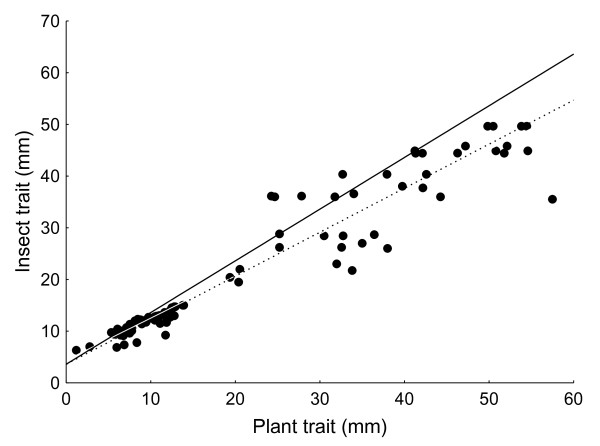
Plant-insect trait-matching at the population level. Scatter plot showing population means for insect and plant morphological traits from all the studies in Table 1 (excluding autonomous selfing plants). Solid line: slope of unity (intercept assumed to be the same as the value derived from the RMA regression intercept: 3.61); Stippled line: RMA derived slope through all data (slope: 0.851 ± 0.026; t90 = 5.7242, p < 0.0001).